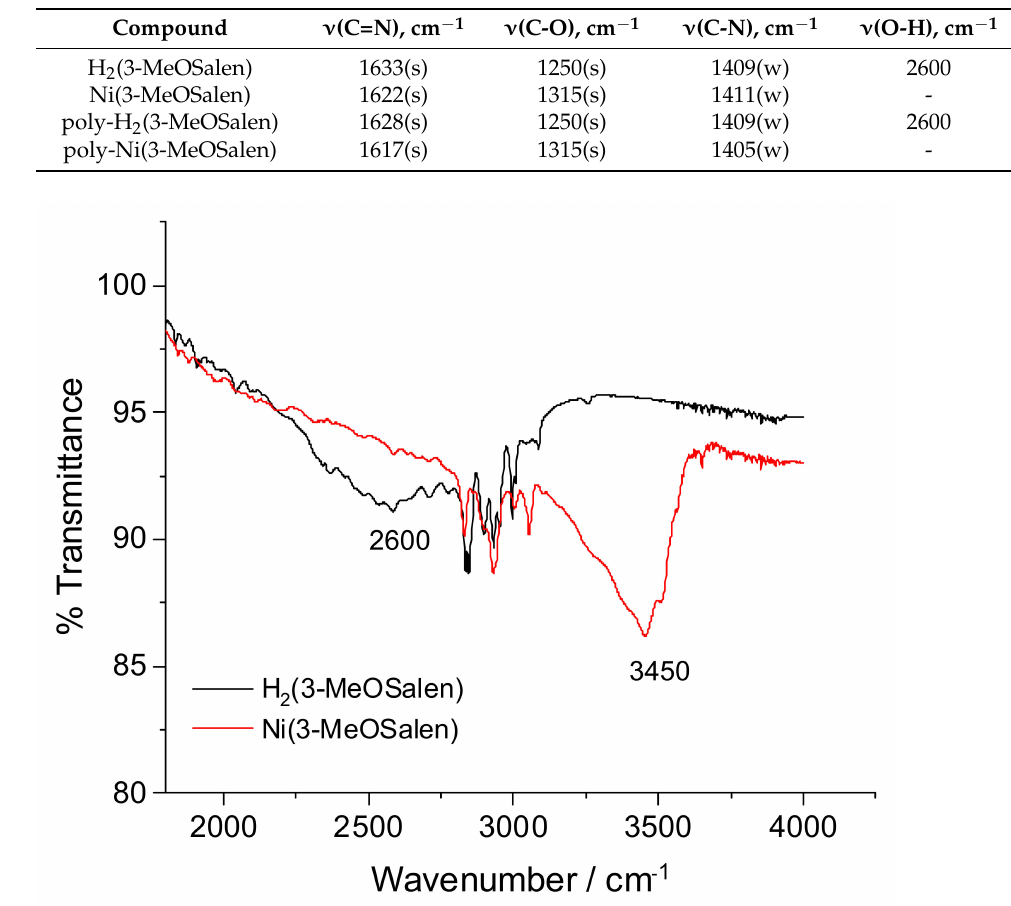
Table 1. Infrared spectra frequencies (cm − 1 ) for the investigated monomeric and polymeric compounds.